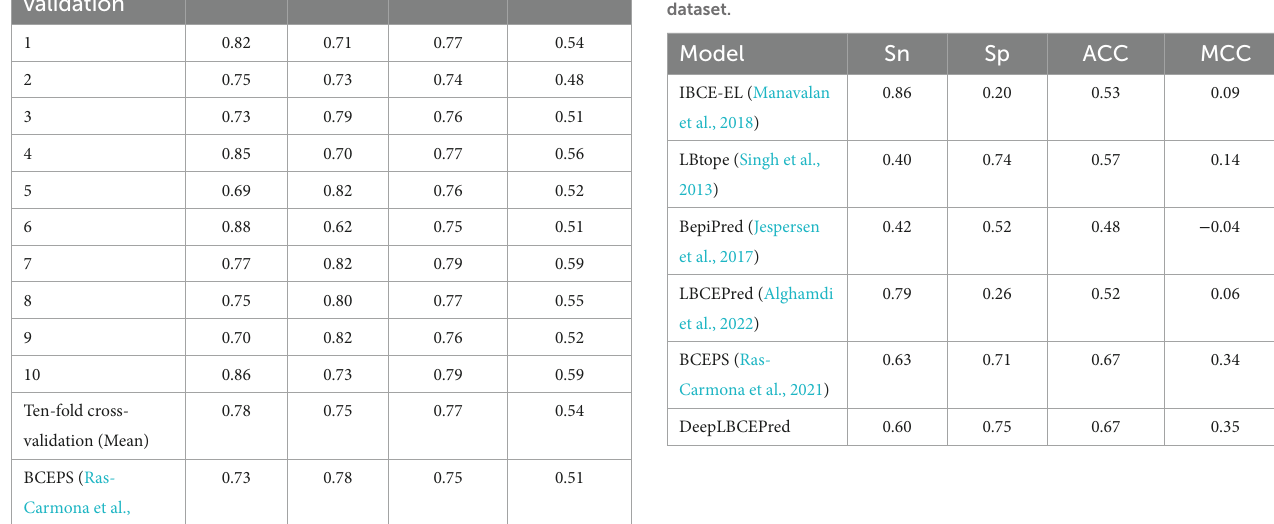
TABLE 4 Ten-fold cross-validation results of DeepLBCEPred. Ten-fold cross-